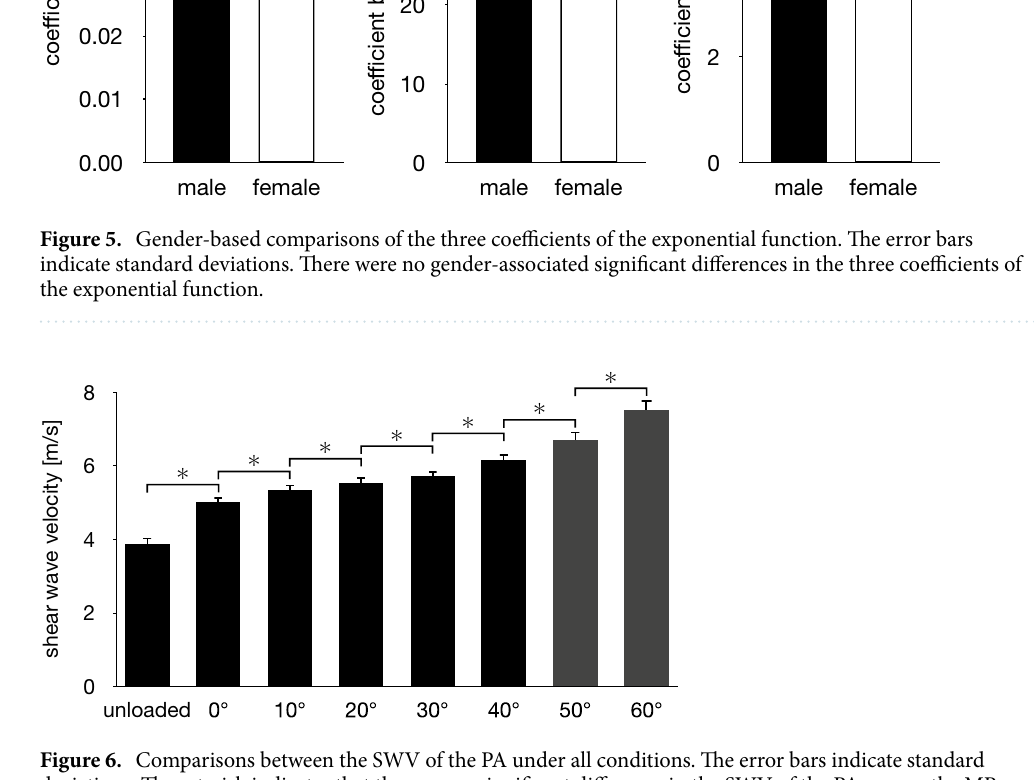
Figure 6. Comparisons between the SWV of the PA under all conditions. The error bars indicate standard deviations. The asterisk indicates that there was a significant difference in the SWV of the PA among the MP joint angles.